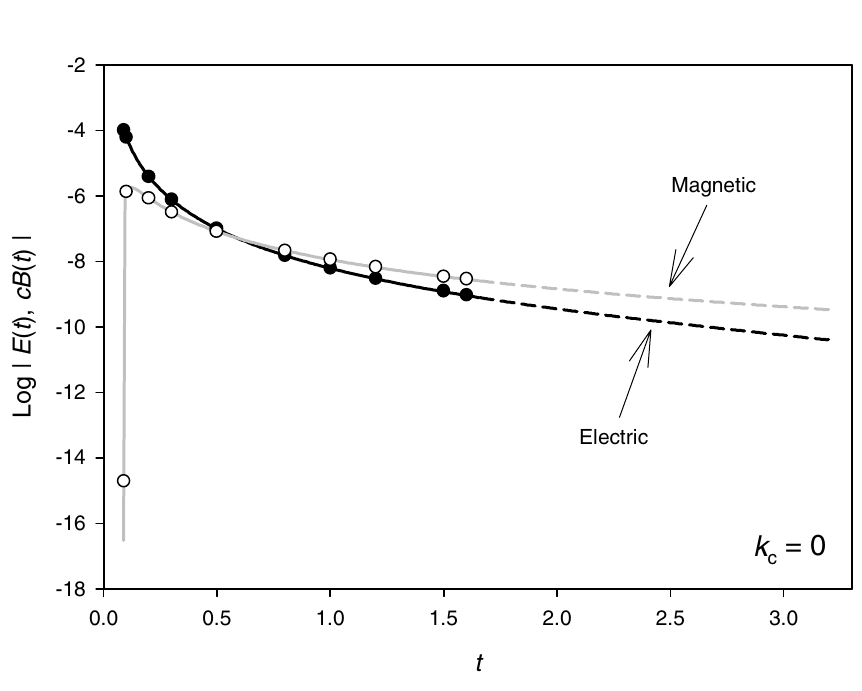
Fig. 1 – The graphic shows a comparison between the analytical and the numerical solutions for the fields in the k c = 0 universe. A description of the symbols is given in the